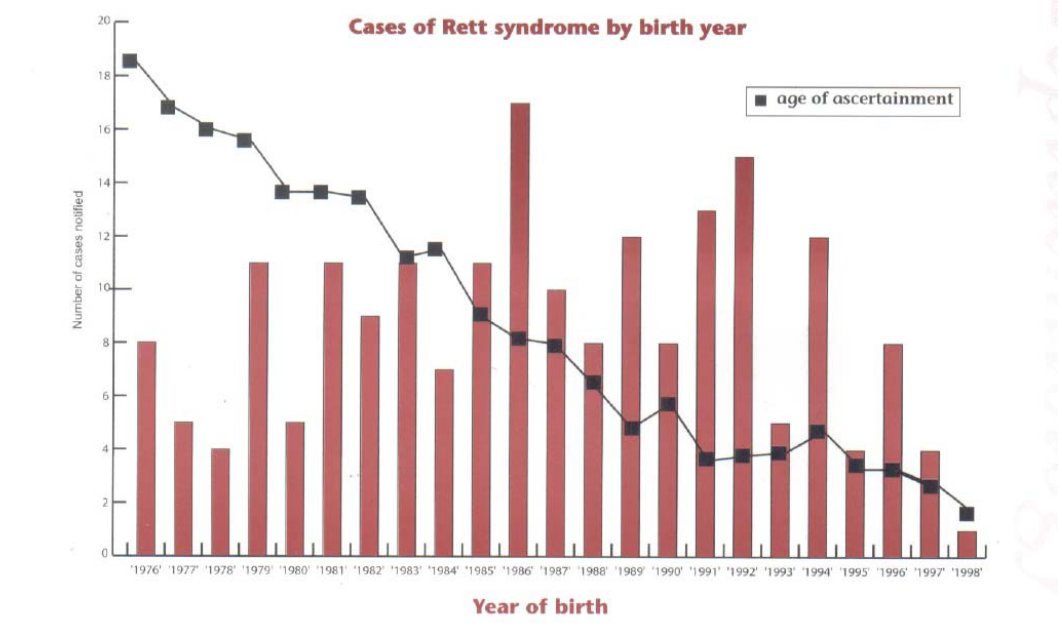
FIGURE 1. Case of Rett syndrome, ascertainment by birth